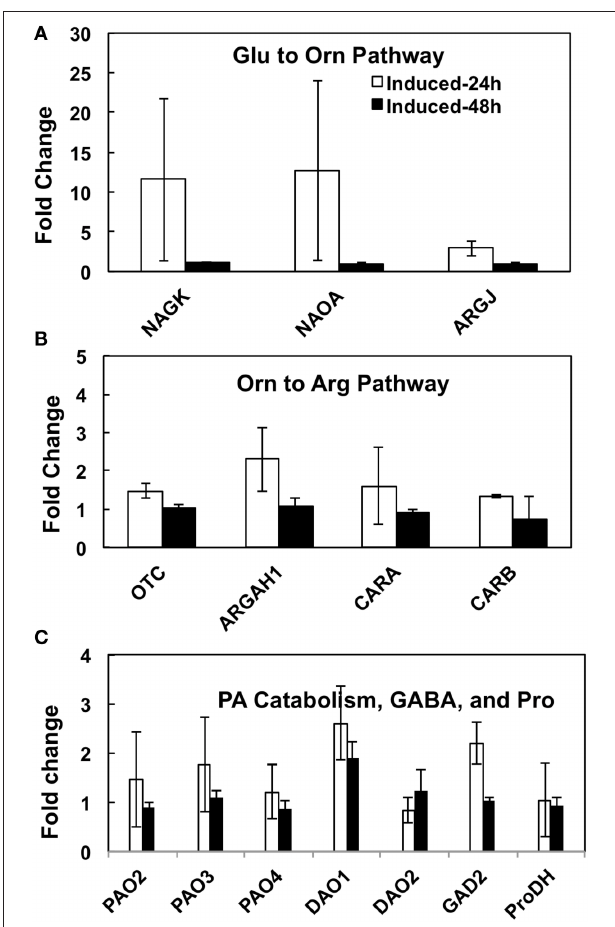
FIGURE 8 | The effects of inducible increase in putrescine production on changes in the relative expression of various genes of (A) Glu to Orn, (B) Orn to Arg, and (C) PA catabolism and GABA biosynthesis pathways in Arabidopsis thaliana . cDNA from transgenic m ODC induced and un-induced seedlings collected at 24 and 48h after induction with estradiol were used with gene specific primers for qPCR. The qPCR assays were conducted with two technical replicates per biological replicate (see details in Supplemental Table 2). Data are Mean ± SE of 3 biological replicates. For explanation of enzymes names refer to legend to Figure 1 and for gene names refer to Supplemental Table 1. The bars represent fold change in gene expression in the m ODC induced as compared to the un-induced control seedlings. * Denotes difference between m ODC induced seedlings and the corresponding un-induced control plants at the same time of analysis where the difference is significant ( P ≤ 0.05) and at least 2 fold; differences that were significant but ≤ 2 fold are not